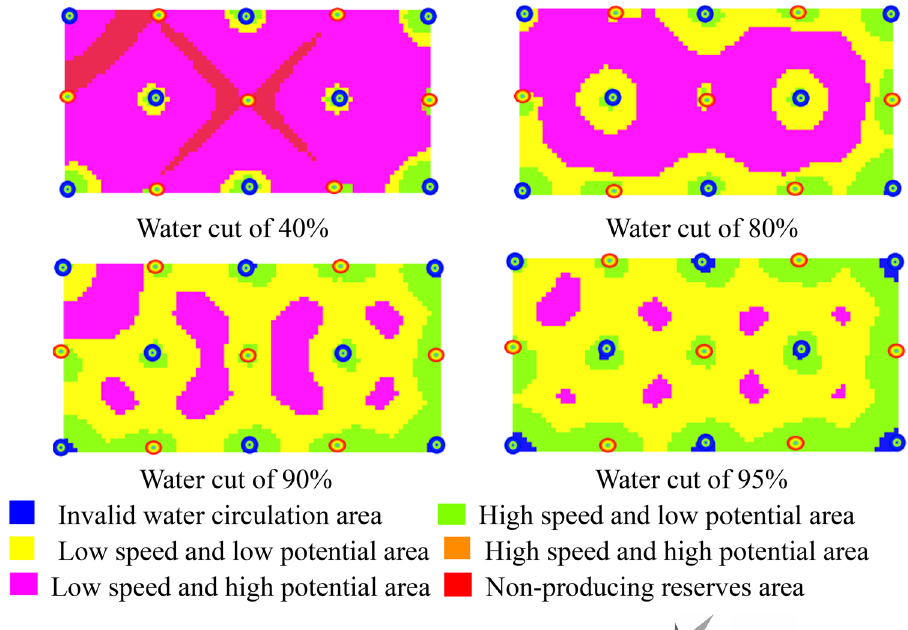
Fig. 9 Seepage field partition diagram of oblique permeability